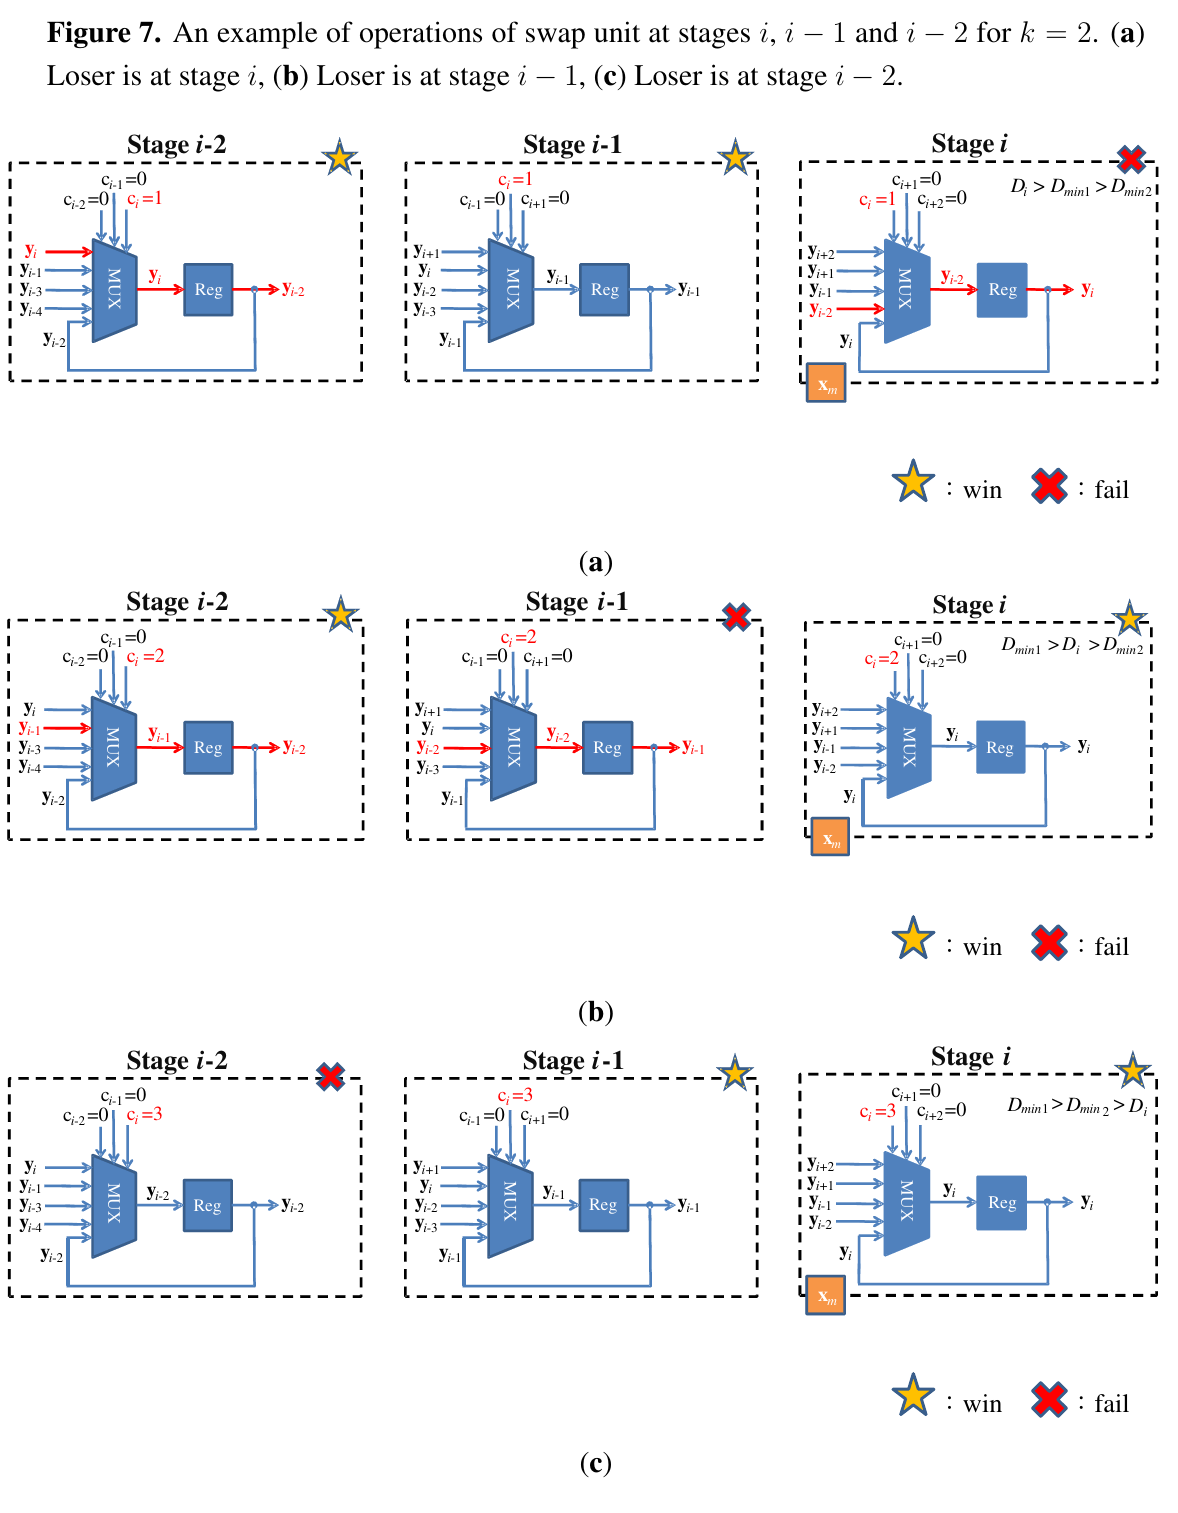
Figure 7. An example of operations of swap unit at stages i , i − 1 and i − 2 for k = 2 . ( a